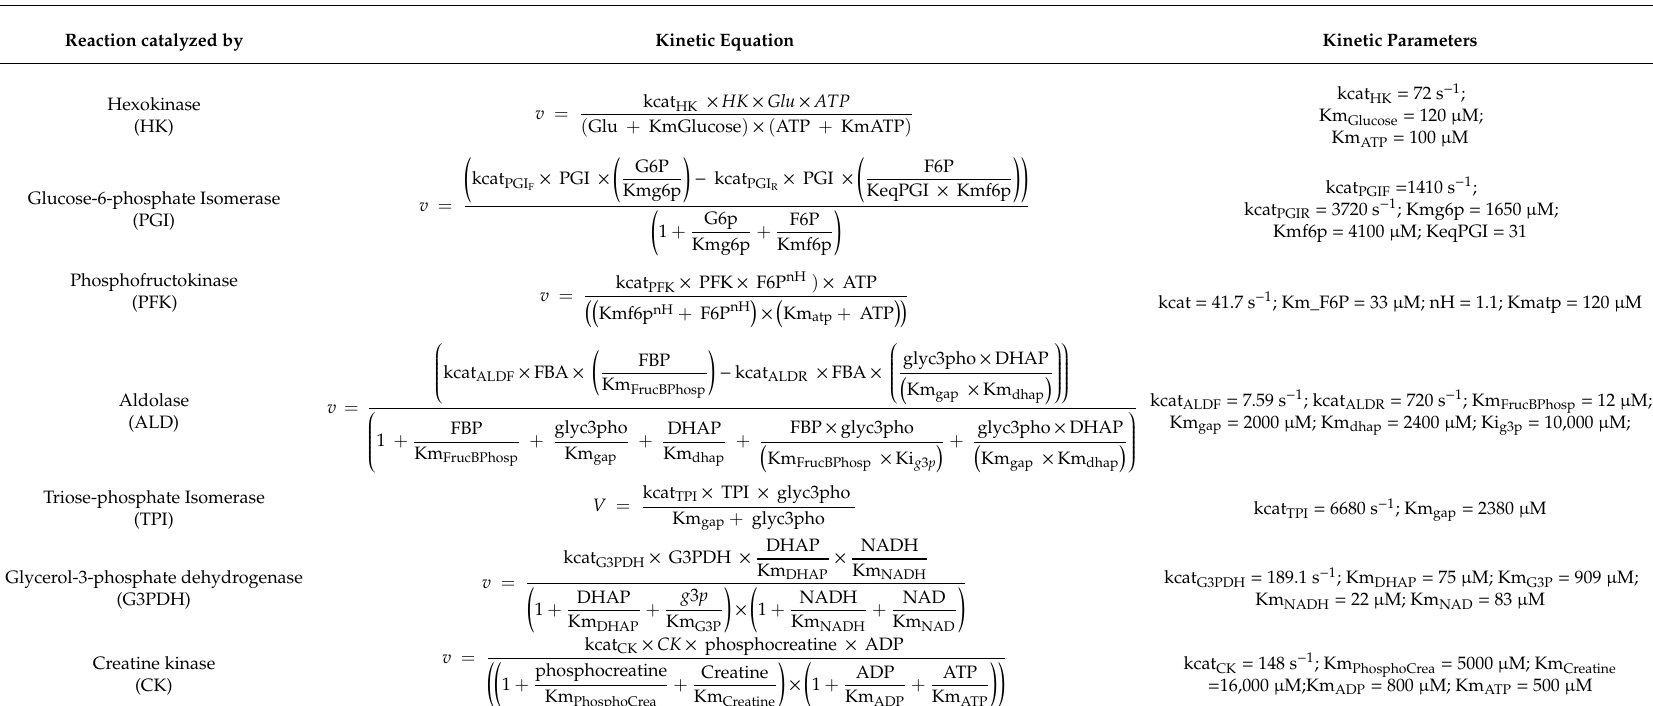
Table 1. The kinetic equations and parameters used to build the kinetic model of the upper part of glycolysis. Glu: glucose; G6P: glucose-6-phosphate; F6P: fructose-6-phosphate; FBP: fructose bisphosphate; DHAP: dihydroxyacetone phosphate. Reaction catalyzed by Kinetic Equation Kinetic Parameters Hexokinase